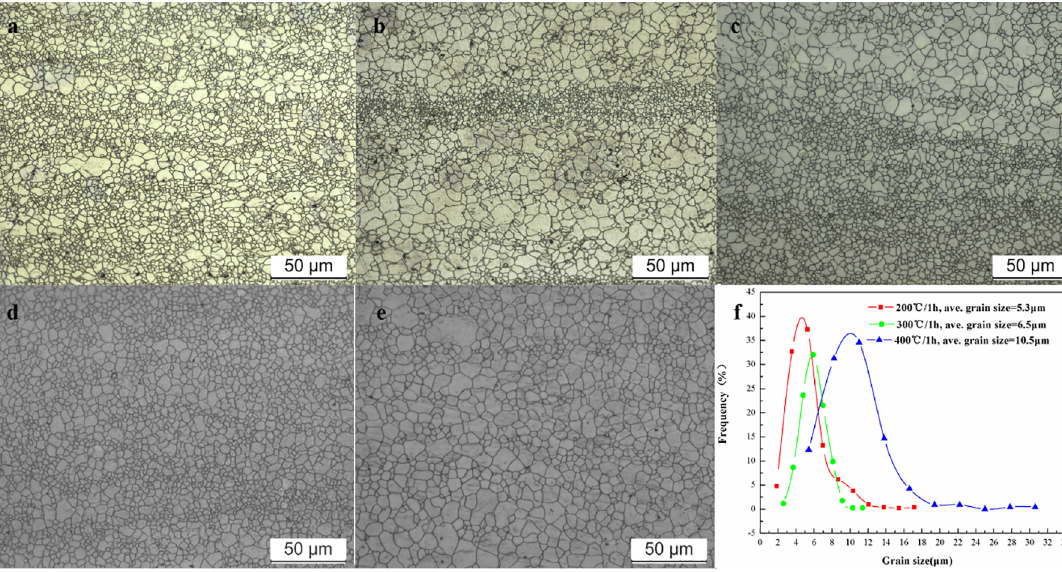
Figure 8a is the thickness of diffusion layer of